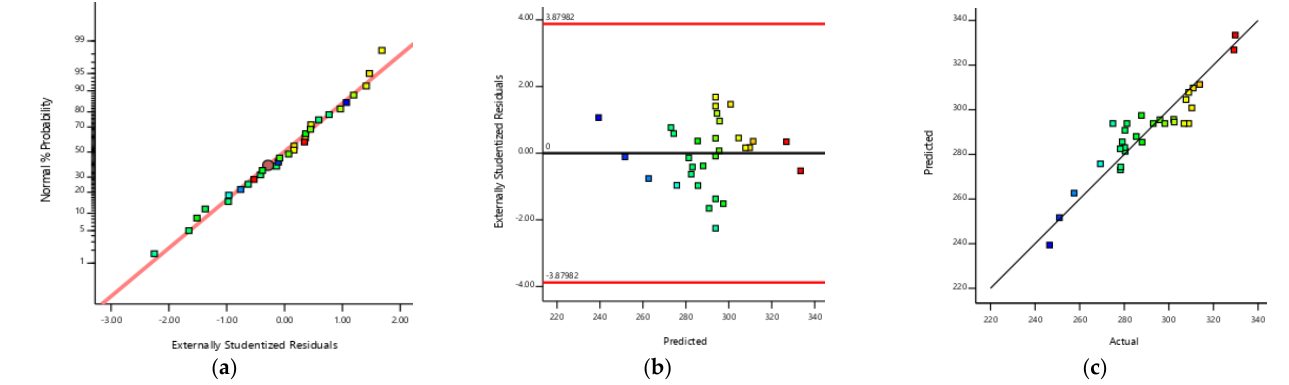
Figure 16. Residual diagnostic plot of the whole straw quadratic model. ( a ) Normal plot of residuals; ( b ) residuals vs. predicted; and ( c ) predicted vs. actual. The values of the bonding parameters are set in the Hertz-Mindlin with bonding module of the EDEM software according to the better parameter values obtained from the above simulation tests, as shown in Table 12. Table 12. Whole straw bonding parameters.